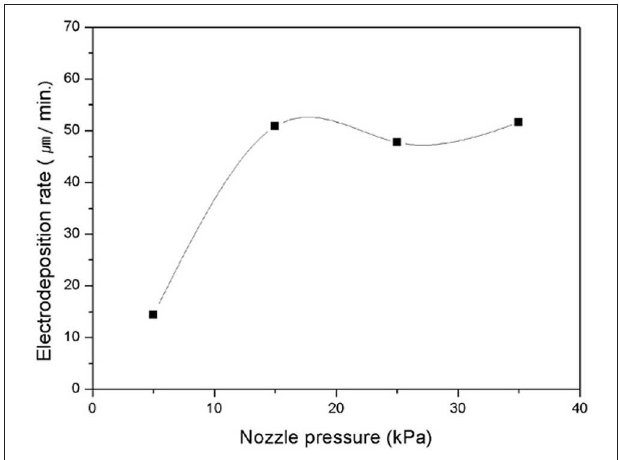
FIGURE 4 | Electrodeposition rate depending on the nozzle pressure.